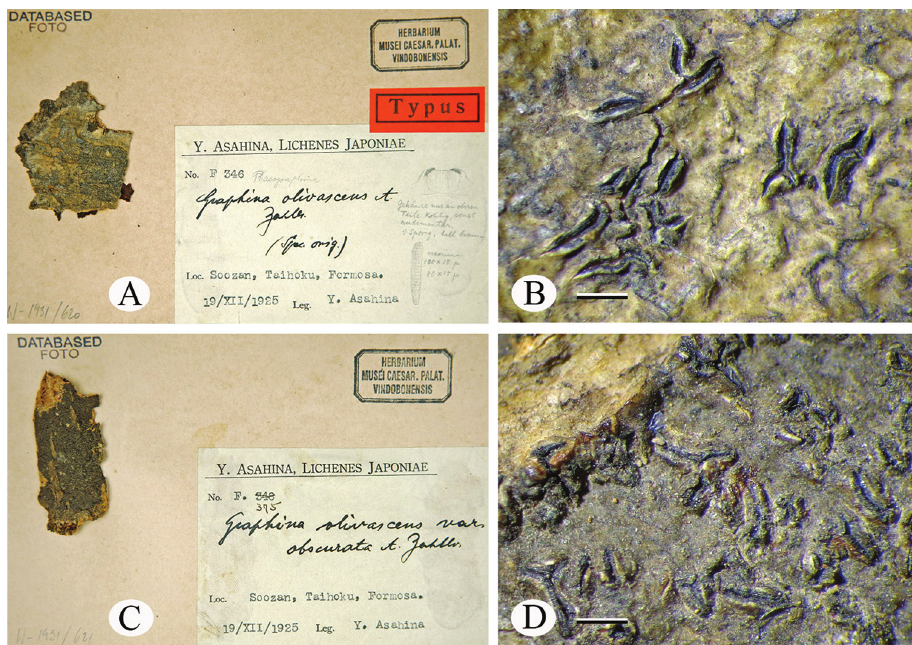
Figuer 3. A, B Type Graphina taiwanensis ( Asahina 346 ) C, D Graphina taiwanensis f. obscurata ( Asahina 346